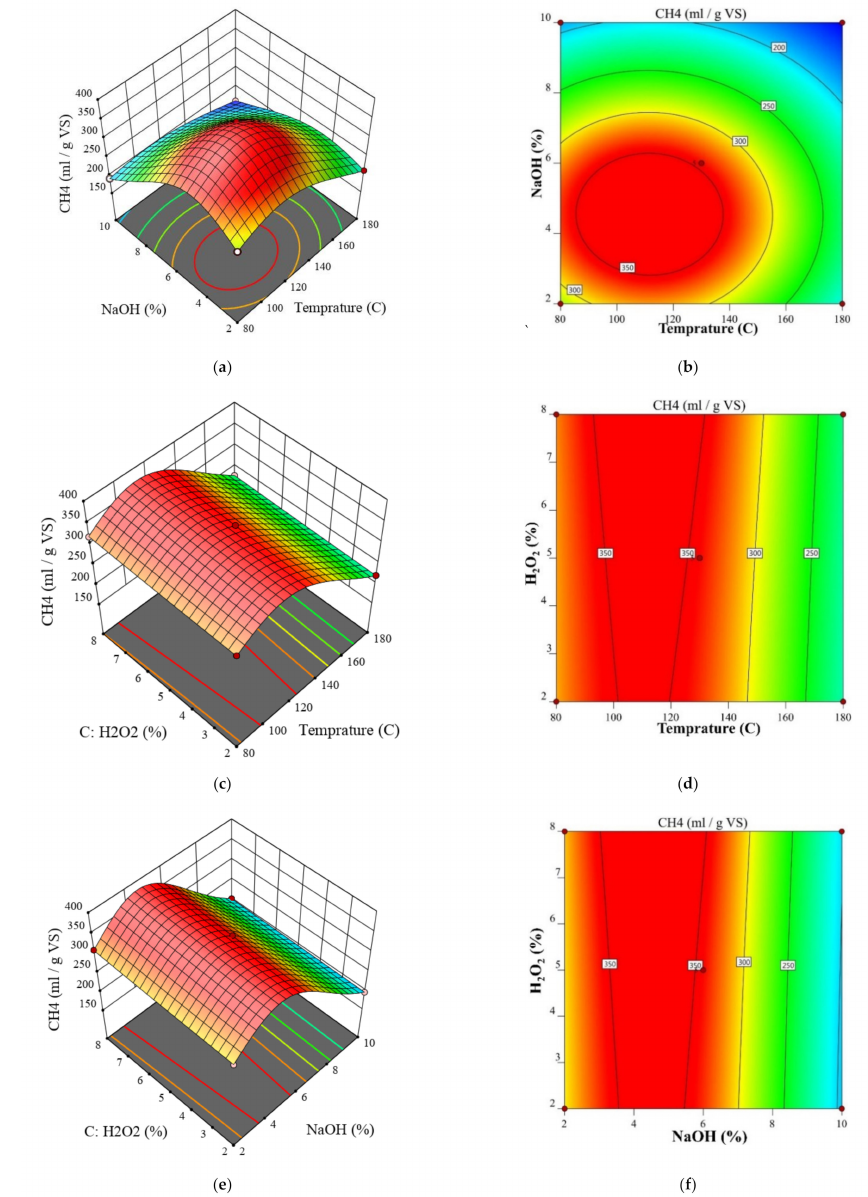
Figure 2. Interaction of pretreatment temperature, NaOH concentration and H 2 O 2 concentration on the biomethane production ( a , c , e ) 3D diagram, ( b , d , f ) contour diagram. The biomethane yield is plotted against the H 2 O 2 content and temperature in Figure 2c. As seen, as the temperature or H 2 O 2 content rises, the biomethane yield peaks and